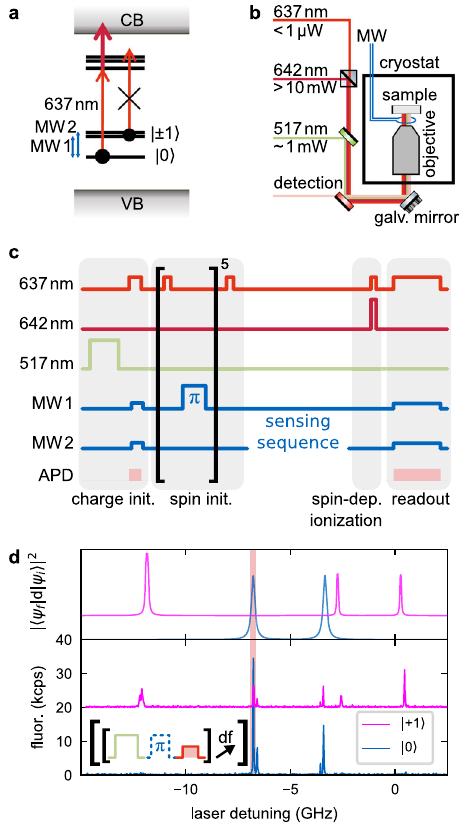
Fig. 1 Main idea of the readout scheme. a Energy levels (simpli fi ed) of an NV − center in diamond. Initially, the NV − center is in its (optical) ground state with spin state either |0 〉 or |±1 〉 . If the spin state is |0 〉 , a gated laser tuned to a |0 〉 transition (637 nm; thin light red arrow) can excite the NV − center, while spin |±1 〉 is protected against excitation. A second gated high- power laser (642 nm; bold dark red arrow) can ionize from the excited state. The blue arrows indicate the microwave (MW) transitions used below. CB/VB denote the conduction/valence band of the diamond host material. b Schematic of the setup. Three individually gated lasers can illuminate the sample, which is mounted in a fl ow cryostat. In addition, the sample can be driven by two MW frequencies. c Final pulse sequence. Red, dark red, and green correspond to gated 637 nm resonant, 642 nm, and 517 nm laser excitation. Blue refers to MW drive. During photon acquisition ( ‘ APD ’ ; rose shade) for postselection and fi nal data acquisition, cw MW excitation at both ground-state transitions is added to constantly mix the spin state during charge-state readout. d Lower panel: photoluminescence excitation (PLE) spectrum of the deep NV − center that is also used for Figs. 2 and 3. Detuning is denoted from 637.20 nm. Off-axial strain is estimated to be 1.7 GHz. The inset shows the used pulsed sequence; ‘ df ’ indicates a change of the laser detuning. Upper panel: simulated spectrum according to Doherty et al. 10 . Red highlighting indicates the transition used